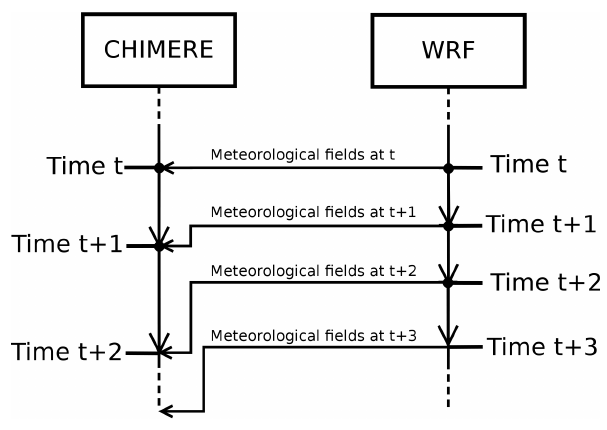
Figure 2. Operations scheduling in a WRF-CHIMERE online sim- ulation with OASIS exchange from WRF to CHIMERE only.